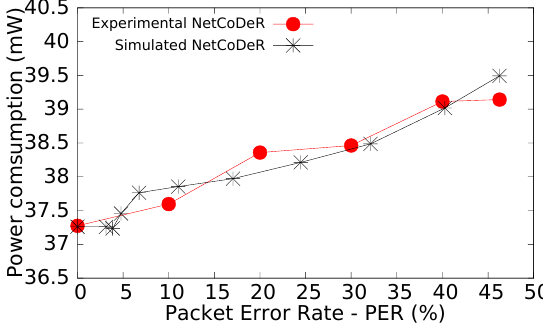
Figure 8. Power consumption of node: Experimental vs.